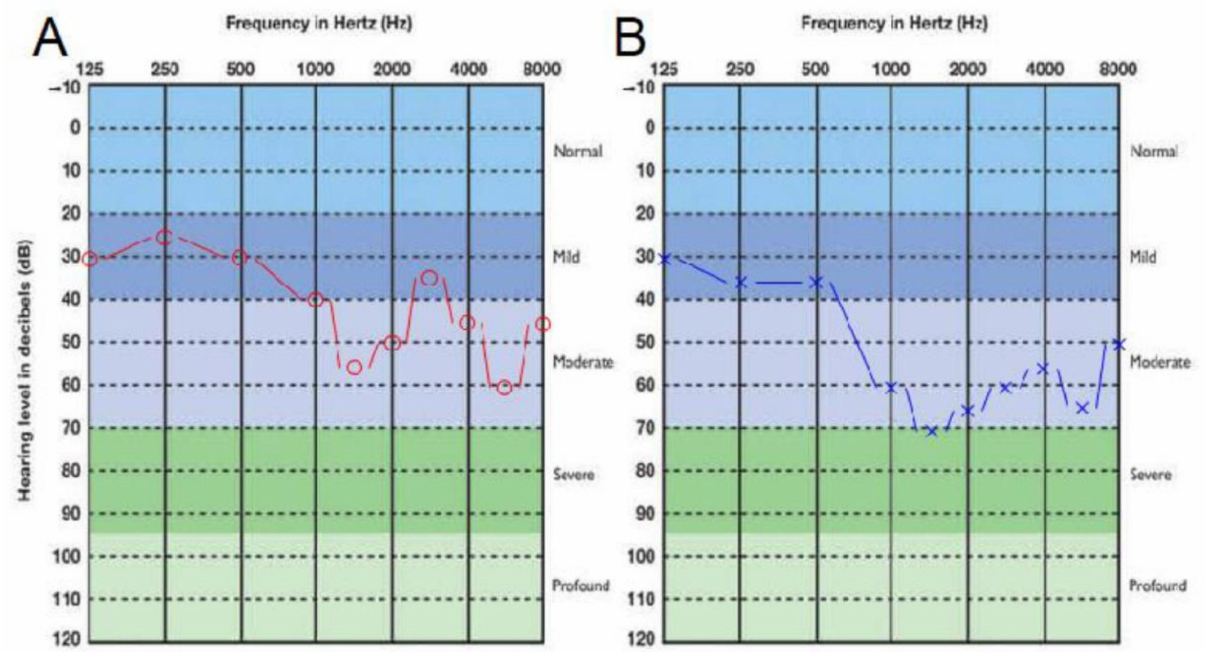
Figure 1. Pure-tone audiogram data of the daughter at first admittance: ( A ) right ear and ( B ) left ear. Red and blue line depict air conduction hearing